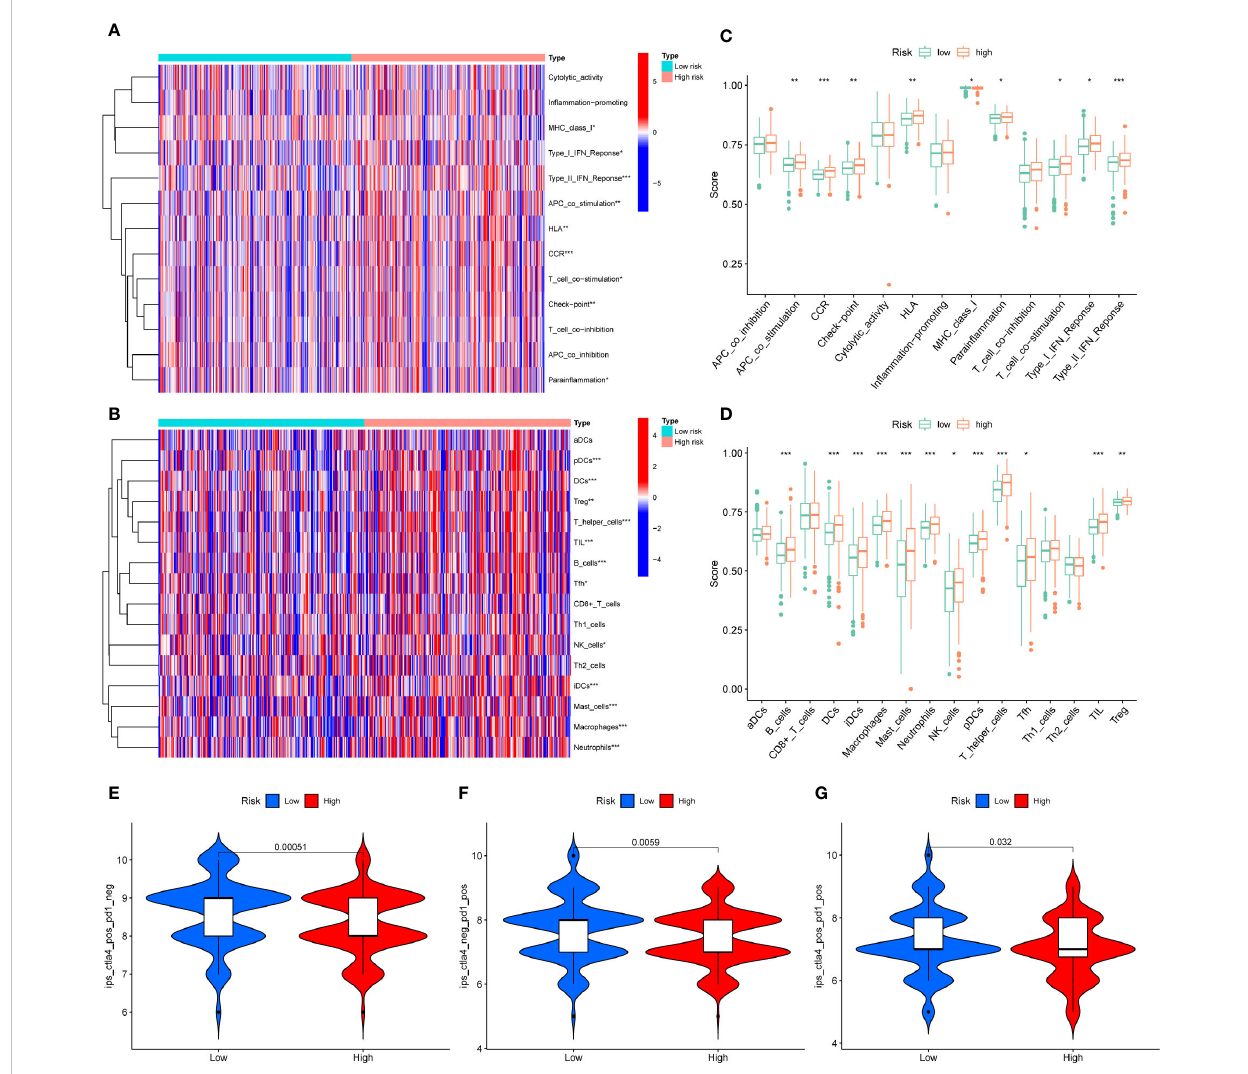
FIGURE 8 Differences in TME in different risk groups. (A) Heatmap of 13 immune-related terms in CRC samples. (B) Heat map of 16 types of immune cell in fi ltration in CRC samples. (C) Difference analysis of 13 immune-related terms in high-risk group and low-risk group. (D) Difference analysis of 16 kinds of immune cell in fi ltration in high-risk group and low-risk group. (E – G) Difference analysis of IPS scores between high-risk and low-risk groups. * represents p < 0.05, ** represents p < 0.01, and *** represents p <